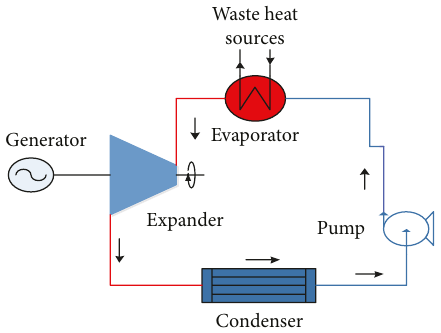
Figure 1: Schematic diagram of ORC-based waste heat